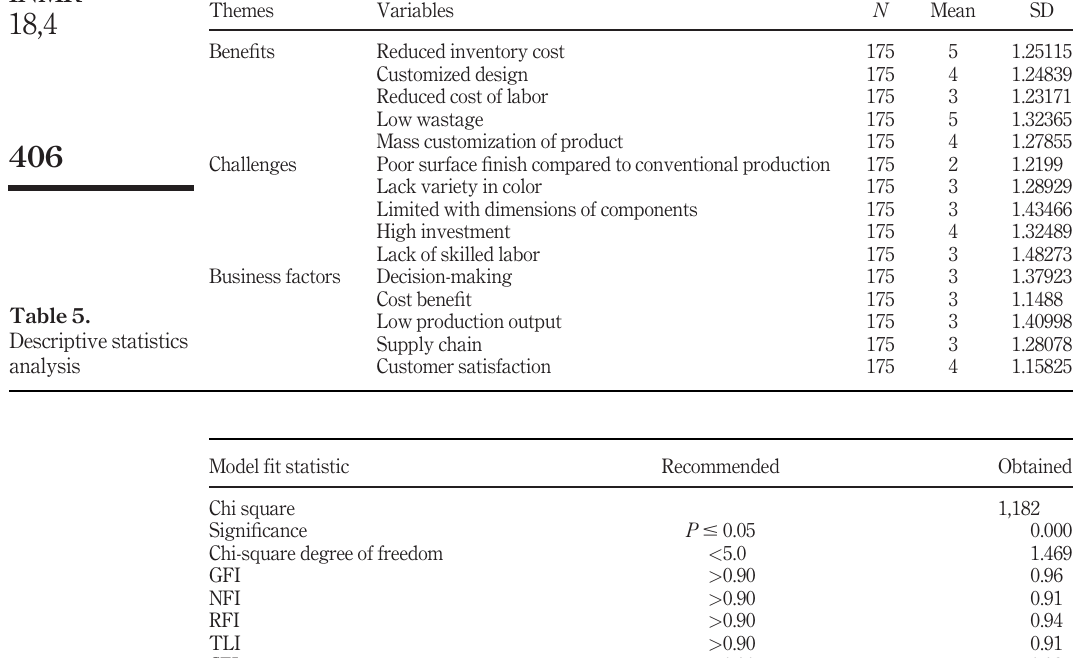
Table 6. Model fi t statistics of the measurement